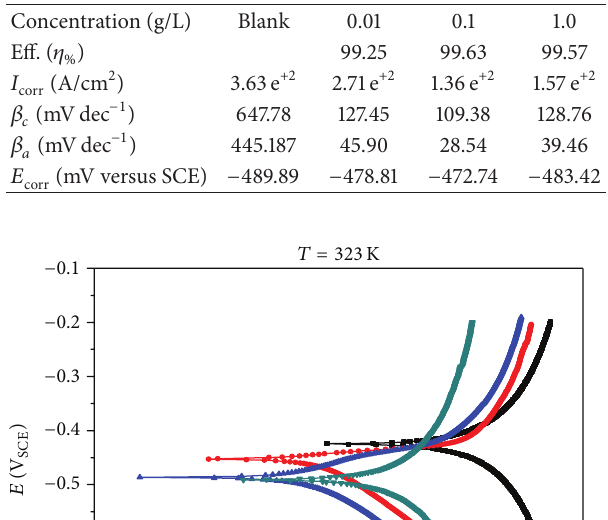
Table 3: Potentiodynamic polarization parameters for pipeline SO with and without different concentrations of steel in 0.5 M H 2 4 Brassica oleracea extract at 313 K.